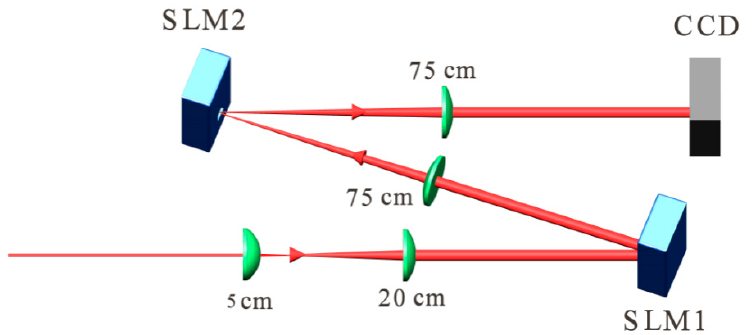
Figure 2. Sketch of the cascaded SLM system.